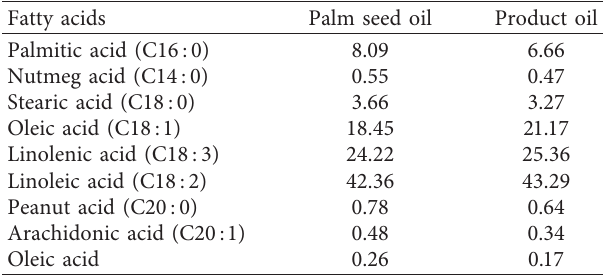
Table 12: Fatty acid composition and content (%) of palm seed oil. Fatty